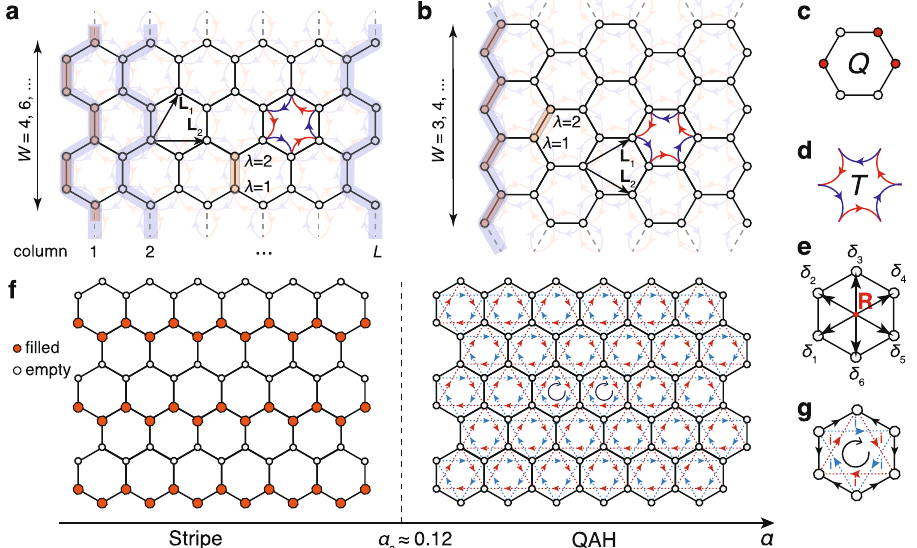
Fig. 1 The honeycomb moire lattice model and phase diagram. a YC and b XC geometries with PBC along vertical ( L 1 − L 2 for XC and 2 L 1 − L 2 for YC) and OBC along horizontal direction. The number of sites on the cylinders is N = W × L ×2, with length L (the number of vertical armchair/zigzag chains, c.f. the gray- shaded lines) and W is the number of 2-site unit cells (c.f. the red-shaded rectangles) along those chains. c Shows the cluster charge operator Q ⎔ , which counts the electron number in a hexagon and d demonstrates the assisted hopping term T with alternating-sign structure. e The labeling of six sites within hexagon R . f The phase diagram contains two distinct insulating phases, i.e., the stripe phase for α < α c , and the QAH state for α > α c ≃ 0.12. g The schematic plot of the emergent current through a mean- fi eld tight-binding analysis of the QAH state. Fig. 2 Identi fi cation of two insulating phases. a The ground-state energy h ψ j ^ H j ψ i , shown as a function of α , with total number of per site e g (cid:3) 1 g g N i the DMRG ground state. b Entanglement entropy sites N = 2 WL and j ψ g S E , c stripe order parameter C n ( M ), d both correlations h J i NN and h J i NNN , are shown versus α , all showing abrupt changes of behavior at α c ≃ 0.12. The mean- fi eld energies for both phases are as well shown in a . The detailed entanglement pro fi le S E vs. subsystem x is shown in the inset of ( b ), and C n ( k ) vs. k in the fi rst Brillouin zone (BZ) shown in the inset of ( c ). NATURE COMMUNICATIONS| (2021) 12:5480